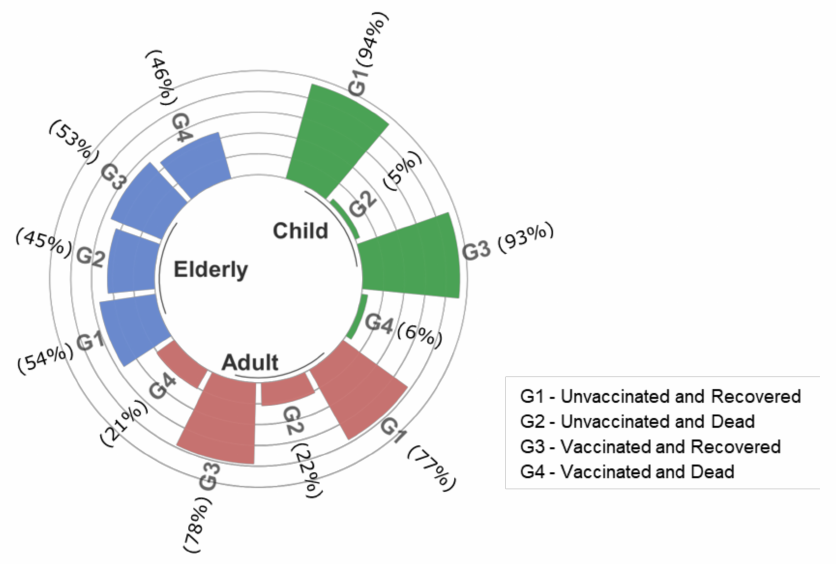
Figure 4. In-hospital mortality and recovery from January to March 2022 with the predominance of the Omicron variant. “G1” stands for unvaccinated and recovered patients, “G2” for unvaccinated and dead, “G3” for vaccinated and recovered, and “G4” for vaccinated and dead. Age was stratified into three groups: child (0–17 years old), adult (18–59 years old) and elderly (over 60 years